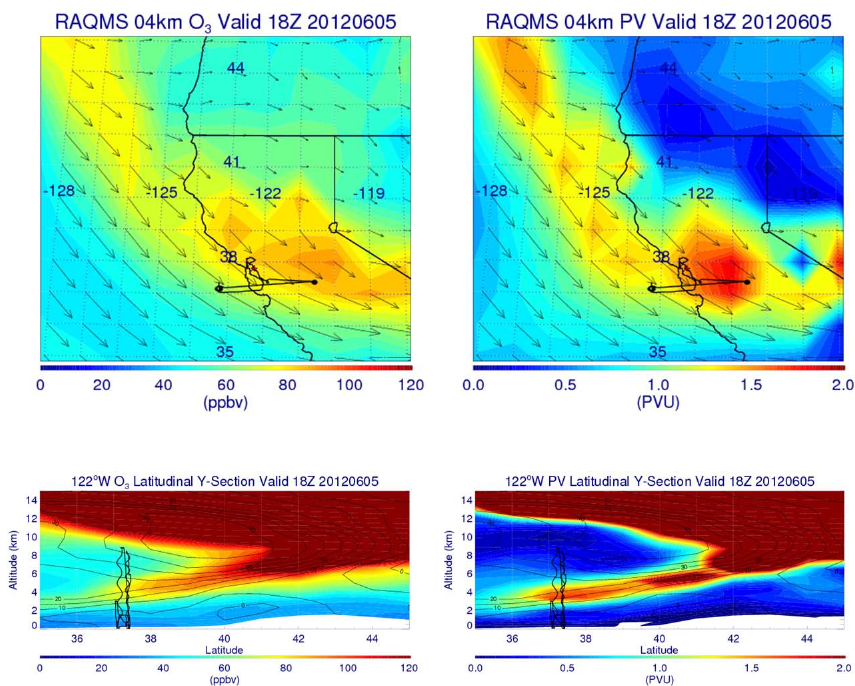
Fig. 7. 4km O 3 (ppbv) and wind vectors (black, upper left) and PV (PVU) and wind vectors (black, upper right) maps with O 3 (ppbv, lower left) and PV (PVU, lower right) cross sections at 120 ◦ W on 5 June 2012 at 18:00UTC from the RAQMS analyses. The aircraft flight track is shown in black, Oakland, located on the San Francisco East Bay, is shown as a red star. Note the tropopause fold indicated by the tongue of relatively strong PV and high O 3 extending from the lower stratosphere into the mid-troposphere. The flight track and observations were taken in a region were PV is <2PVU (bottom right), indicating STT occurrence (i.e., stratospheric air was sampled after crossing the tropopause).